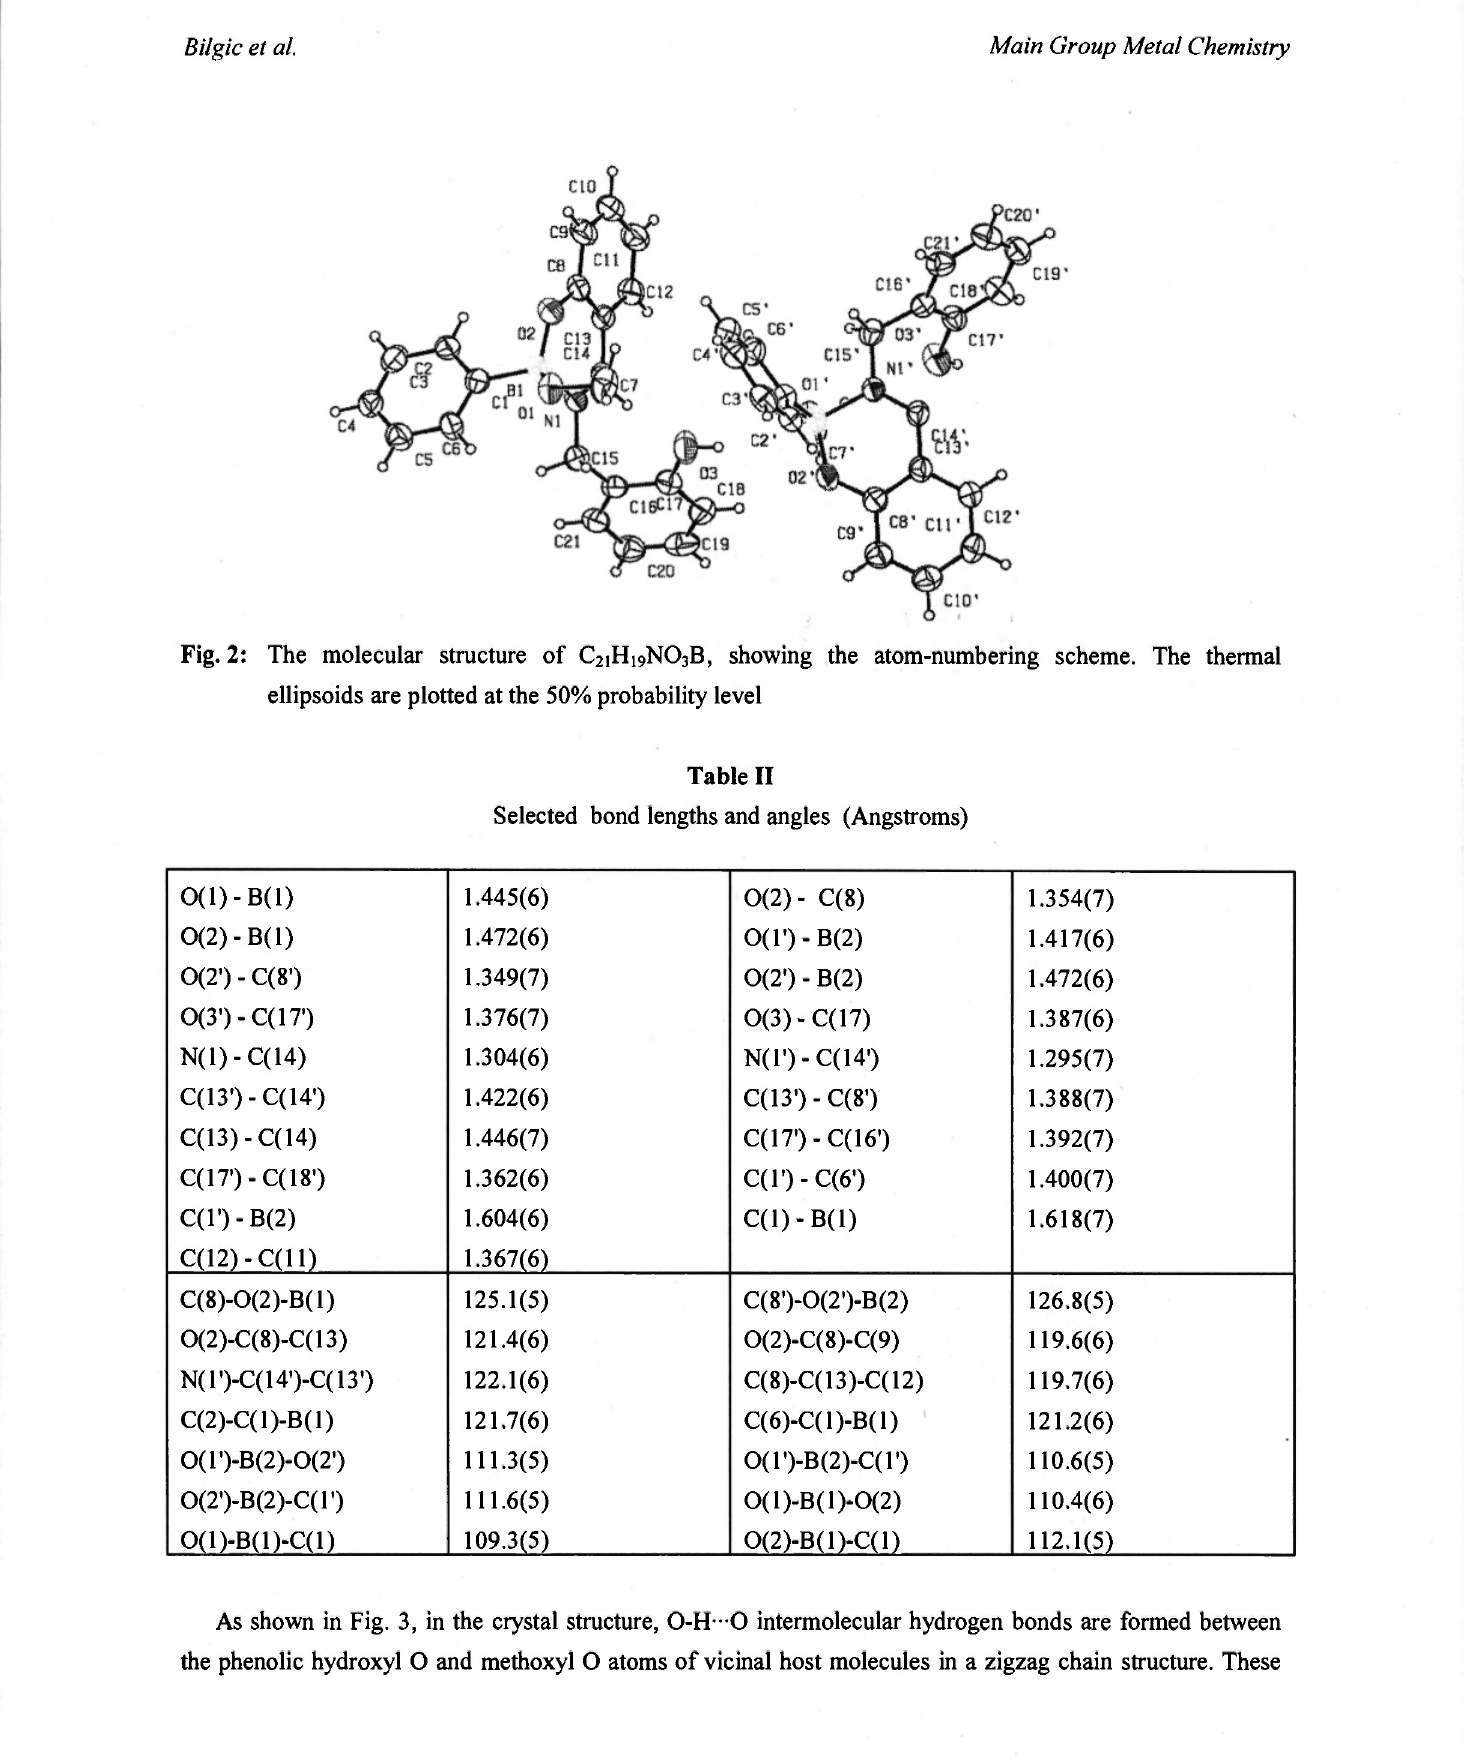
Table II Selected bond lengths and angles